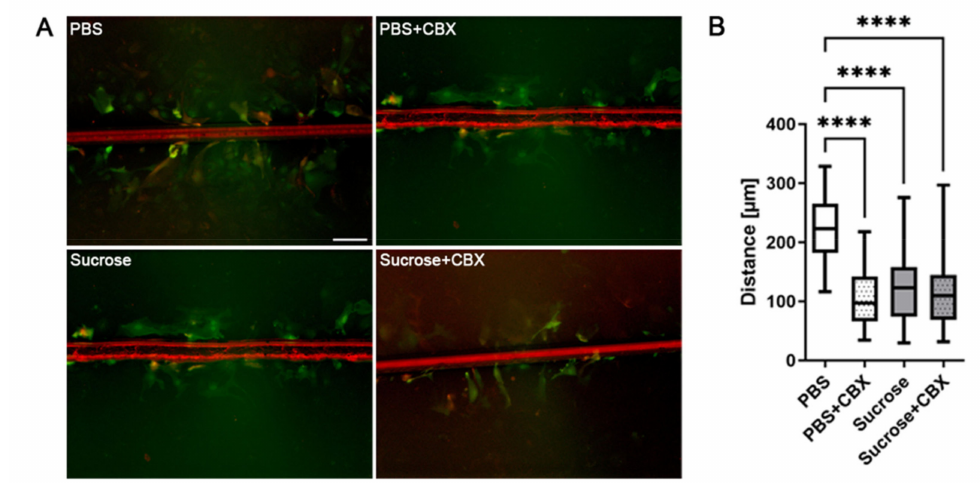
Figure 3. Sucrose inhibits gap junctional intercellular communication (GJIC) to the same extent as the gap junction inhibitor carbenoxolone. Functionally active gap junctions enable transmission of small molecules such as Lucifer Yellow (LY, shown in green) from one cell to neighboring cells, whereas high molecular dyes such as Rhodamine-Dextran (shown in red) are able to enter injured cells but remain there. ( A ) Cells incubated in PBS spread LY within the cellular network. This was reduced by the known gap junction inhibitor carbenoxolone (CBX). Sucrose treatment reduced the dye transfer to a similar extent as CBX, and this effect did not increase further by additional application of CBX (Sucrose + CBX). ( B ) Quantification of the distance of transferred dye (in µ m) of n = 3 experiments are shown as box plots with median and whiskers for minimum and maximum. Statistic significances: **** p < 0.0001. Scale bar for all four images 100 µ